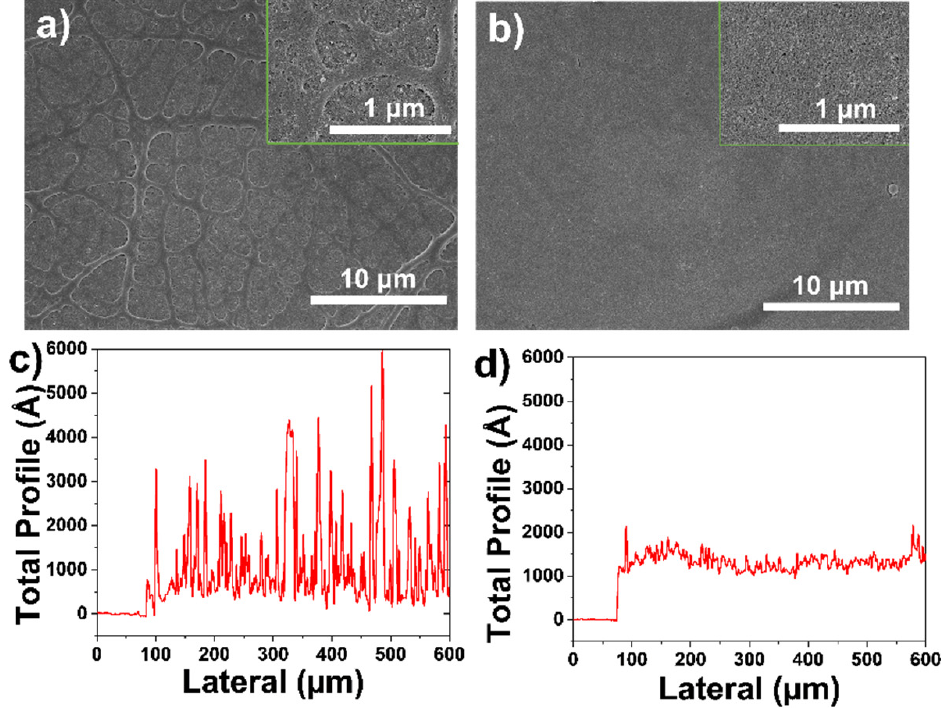
Figure 4. SEM images of film sprayed with ( a ) SiO 2 (0.05) and ( b ) SiO 2 /PVP (0.05/0.01); film surface profiles of spraying solution of ( c ) SiO 2 (0.05) and ( d ) SiO 2 /PVP (0.05/0.01).